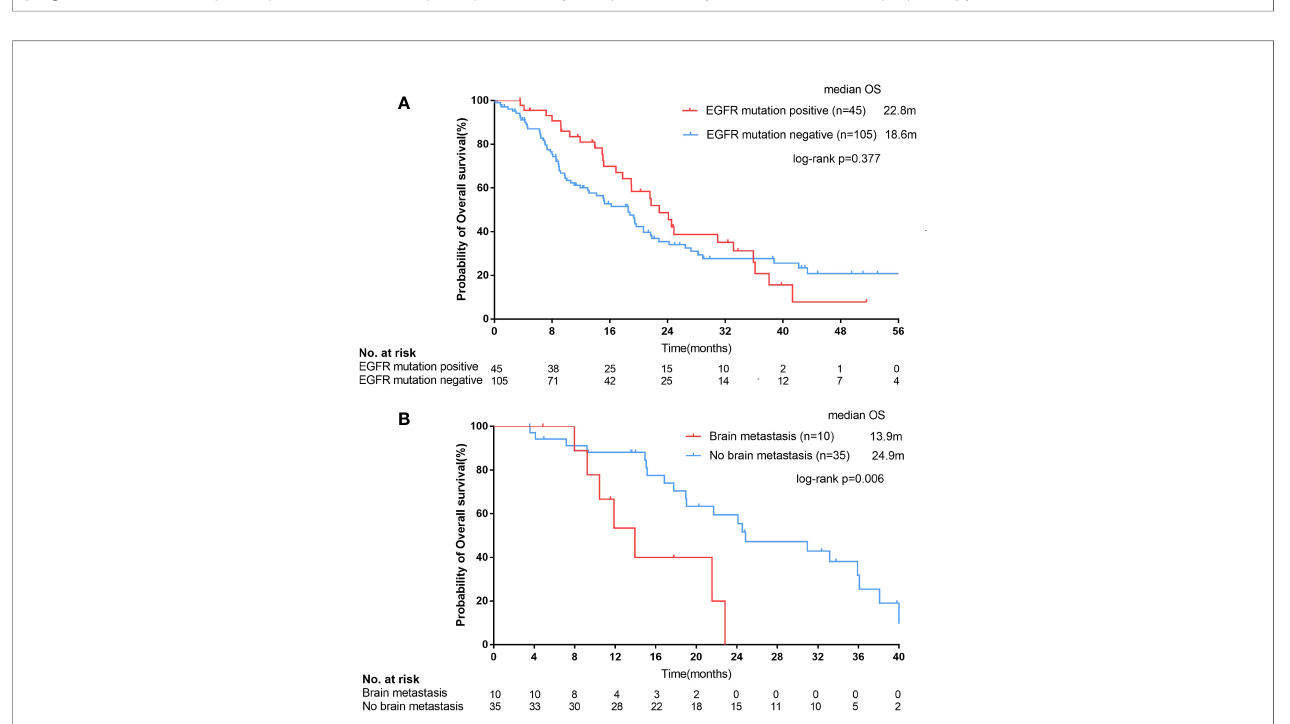
FIGURE 5 | For all female squamous cell carcinoma (SCC) patients, Kaplan – Meier curves of overall survival (OS, A ) strati fi ed by epidermal growth factor receptor (EGFR) mutation status. For SCC patients with EGFR positive mutations, Kaplan – Meier curves of OS (B) strati fi ed by brain metastasis.